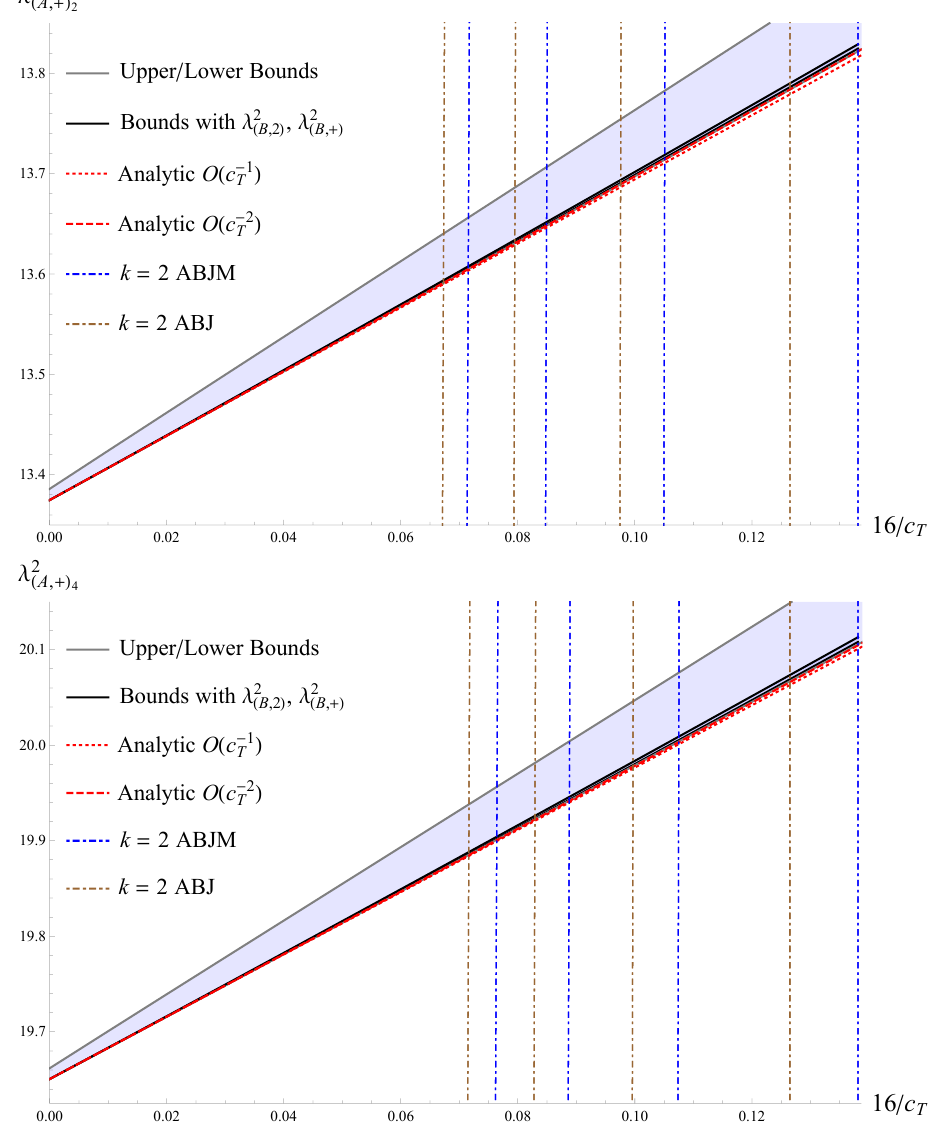
Figure 2 . Upper and lower bounds on the λ 2 (bottom) in terms of the stress-tensor coefficient c T in the large c T regime. The black solid lines are with the all orders in 1 /c T values of λ 2 bootstrap, while the gray solid lines are without any assumptions, and note that the allowed region for the black bounds is much smaller than the gray bounds. The red dotted line denotes the large c T expansion to order tree level supergravity O ( c − 1 line also includes the 1-loop R | R correction at order O ( c − 2 and improves the saturation of the lower bound relative to O ( c − 1 lines denote the values of c T for various known k = 2 ABJM and ABJ theories, respectively, which are summarized in table 4. These plots were made with Λ = 83